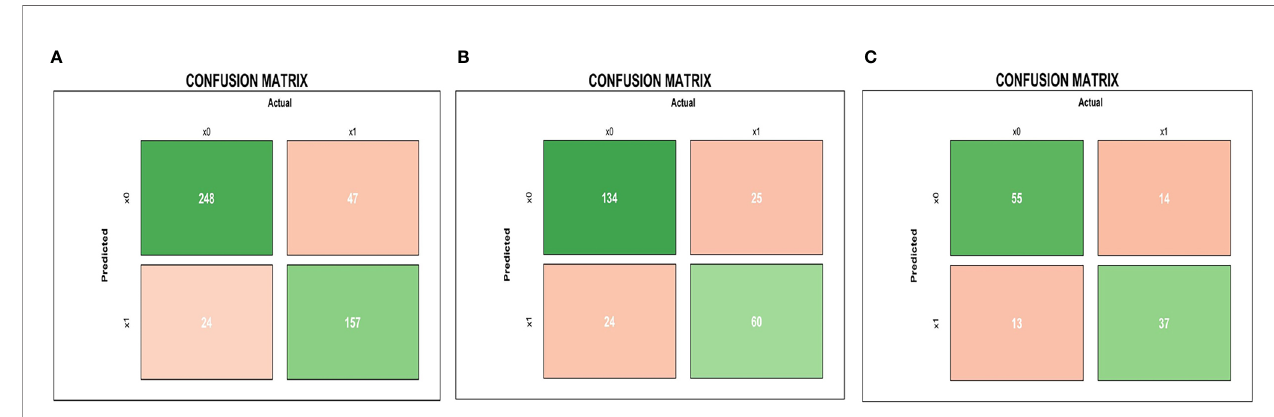
FIGURE 5 | Mid-treatment MRI-radiomics model in each dataset predicted the confusion matrix of PFS in LA-NPC. (A – C) represent the confusion matrix of the MRI-radiomics model of mid-treatment in the training dataset, the original dataset, and the test dataset,